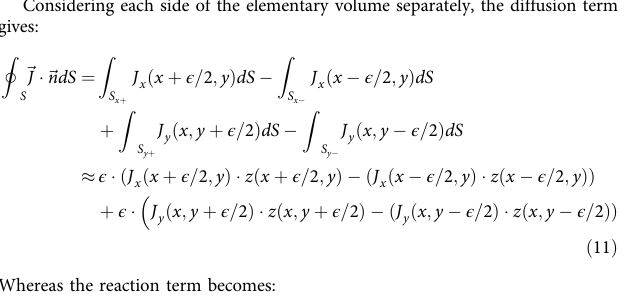
grey-scale intensities was then divided in two groups using the k-means clustering algorithm (Supplementary Fig. 4C) to generate a binary image of black and white pixels (Supplementary Fig. 4D). Closed curves connecting white pixels adjacent to black pixels on the binary image were considered as borders of green chains of scales on the corresponding original image (Supplementary Fig. 4E). The distance of each green pixel (i.e., belonging to the cluster with lower grey-scale intensity; Supplementary Fig. 4C) to the closest border was then normalised by half the average distance between the centres of neighbouring skin scales on the corresponding skin patch (i.e., the average skin-scale radius r avg ). For each pixel belonging to a green stripe, the corresponding normalised distance value is displayed using a colour scale code (Supplementary Fig. 4F). Finally, the global length scale of the pattern was computed as the mean among normalised distances >1. For computing the length scale of simulated patterns, the same procedure was followed; however, as simulation images do not require noise reduction, the clustering threshold was simply set to a value of 127.5, i.e., the centre of the interval of possible pixel intensities. The average curvature of the pattern border, sampled every r avg along the border (white dots in the inset of Supplementary Fig. 5), is computed using the Menger curvature (1/ r M ), i.e., the reciprocal of the radius of the circle (yellow, inset of Supplementary Fig. 5) that passes through the current computation point (purple, inset of Supplementary Fig. 5) and two neighbouring points (blue, inset of Supplementary Fig. 5) whose distance to the computation point is equal to 5· r avg . To scale out image resolution effects, the radius r M of the resulting circle is normalised by r avg . Sensitivity analysis . The prism colour homogeneity error quanti fi es how much a generated steady state deviates from a pattern in which each prism has homo- geneous colour. This measure was constructed by taking all simulation grid points i that fall inside a prism p and calculating the corresponding prism colour homo- geneity error as: e ð p Þ ¼ min ð 1 (cid:2) green ð p Þ ; green ð p ÞÞ ; ð 18 Þ ∑ i 2 p g ð i Þ ð i Þ 2 0 ; 1 ½ (cid:3) is the green colour intensity of a grid where green ð p Þ ¼ j p j and g point i (see above). Finally, we compute the pattern colour homogeneity error ∑ p e ð p Þ consisting of n prisms as (Supplementary Fig. n